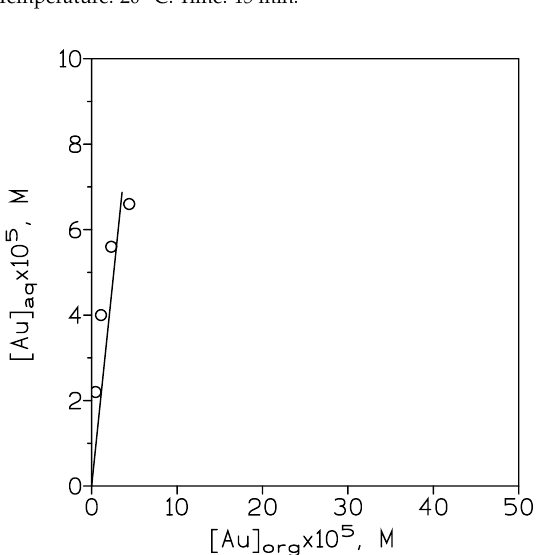
Figure 3. Gold stripping isotherm. Data from results shown in Table 11.